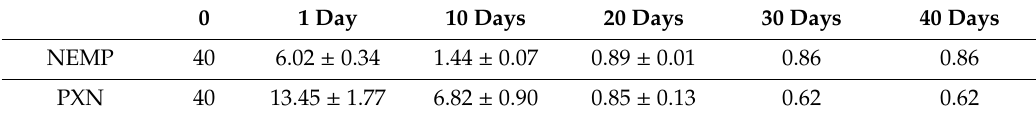
Table 8. Degradation experiment equations for NEMP and PXN.